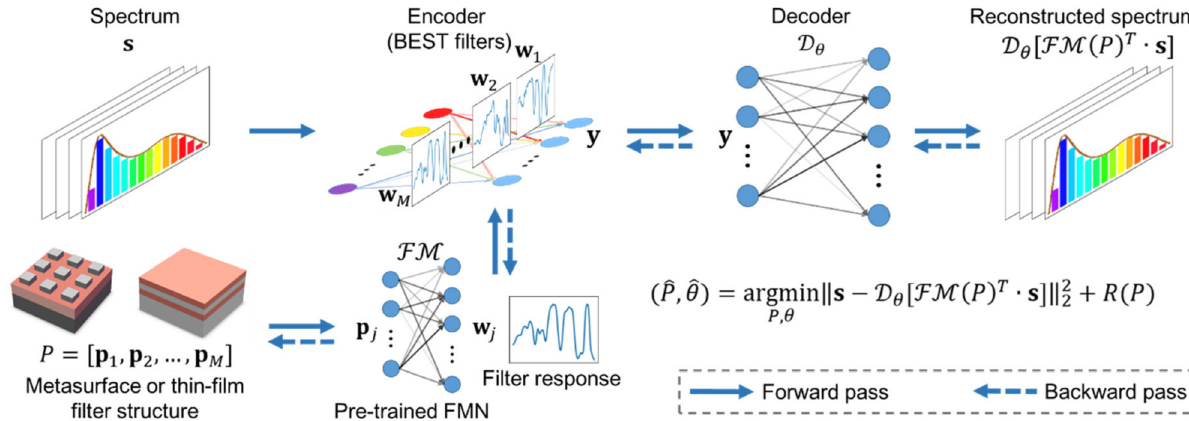
Figure8: Schematicofparameter-constrainedspectralencoderanddecoderdesignframework.Therandomopticalfiltersactasanencoding neural network whose connection weights and filter responses are constrained by the filters ’ structure parameters through a pre-trained forward-modeling network. During eachtraining epoch,a batchof spectrumsis fed intothe encoderandthedecoder givesthe corresponding output, such as the reconstructed spectrums. The loss function, such as the mean square error for the reconstructed spectrum, is evaluated, andtheerrorsarepropagatedbacktothestructureparameters.Underthisframework,theencodingfiltersandthedecoderneuralnetworkare jointly designed. Figure is reprinted with permission from Ref. [106], copyright 2021 WILEY-VCH Verlag GmbH & Co. KGaA,